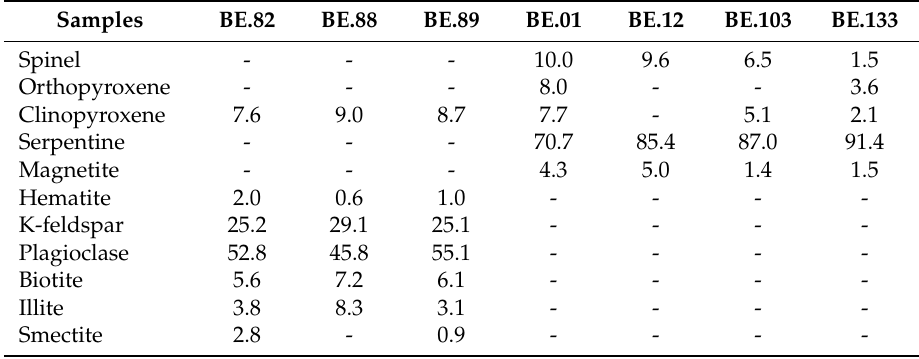
Table 2. Mineralogical composition of the studied rocks from XRD analysis (-: not detected).